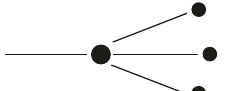
Figure 1: The molecular structure of 𝑅 1 : meythl.